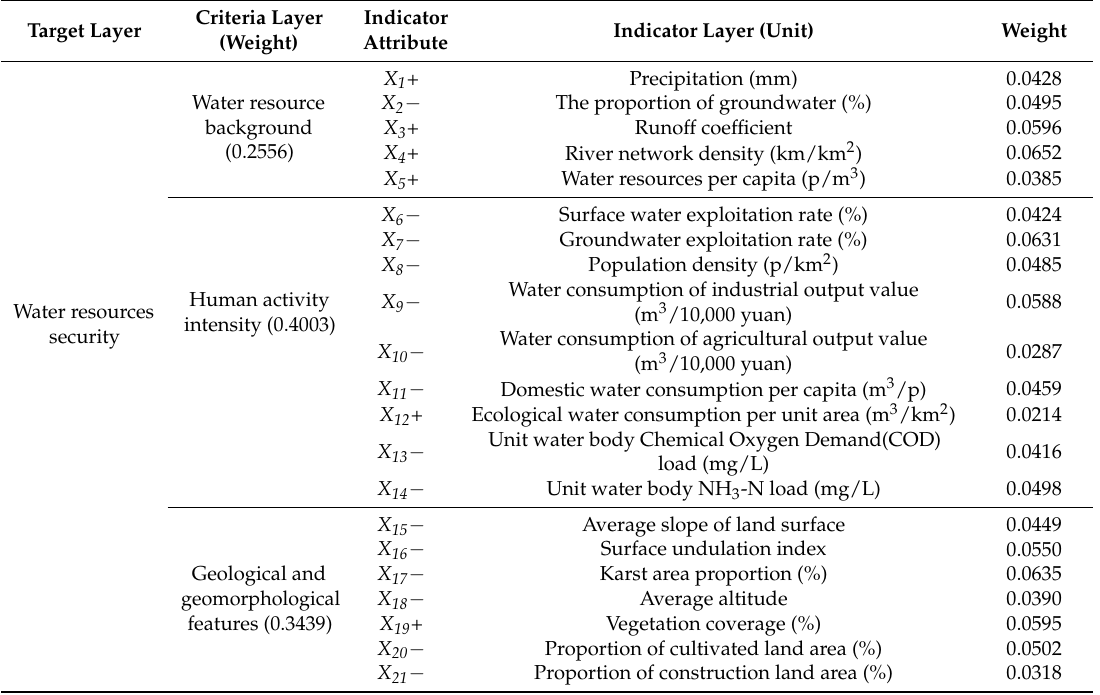
Table 1. Guizhou Province water resources security evaluation index